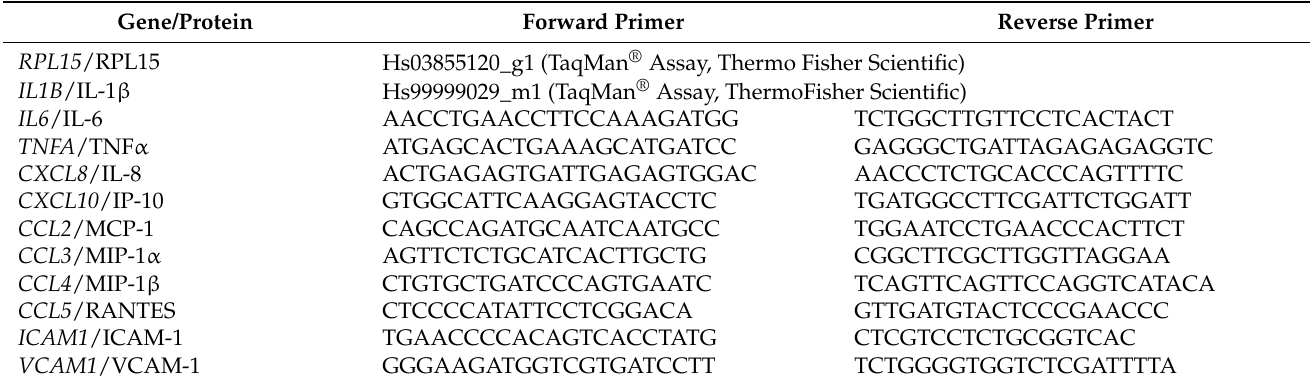
Table 1. Sequence of primers pairs employed for RT-qPCR